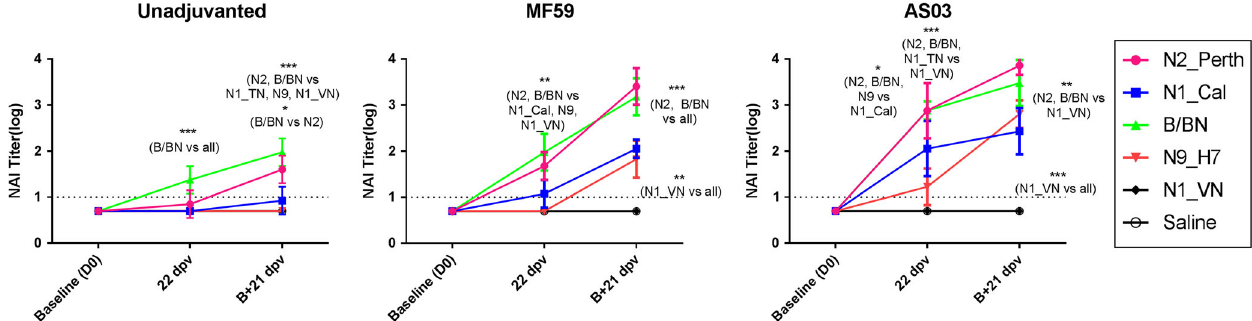
Fig. 3 Antibody titers against NA in ferrets vaccinated with unadjuvanted, MF59 or AS03-adjuvanted TIV, H7N9 or H5N1 vaccines. Sera was collected after the fi rst dose (22 dpv) and second dose (B + 21 dpv) and tested by enzyme-linked lectin assay (ELLA) against homologous antigens. Antibody titers are expressed as mean log 10 -antibody titer, with the error bars representing the standard deviation. Dashed line (at Y = 1) indicates the limit of assay detection. Statistically signi fi cant differences were tested by ANOVA of log-transformed antibody titers for all antigens and vaccine groups and post hoc tests with Bonferroni adjustments for multiple comparisons. Asterisk denotes p -value < 0.05, ** p < 0.01, *** p <